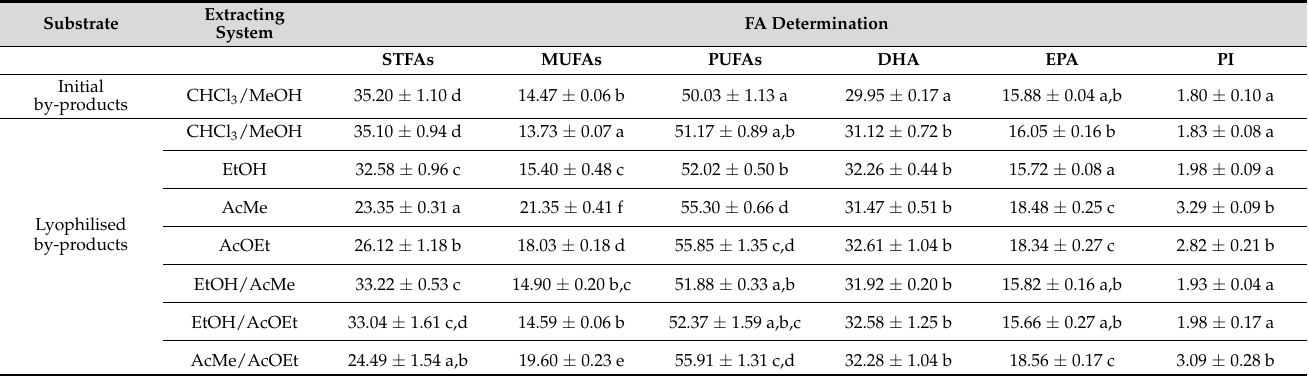
Table 2. Fatty acid (FA) analysis (g · 100 g − 1 total FAs) * in initial by-products and lyophilised by-products obtained by different lipid-extracting systems